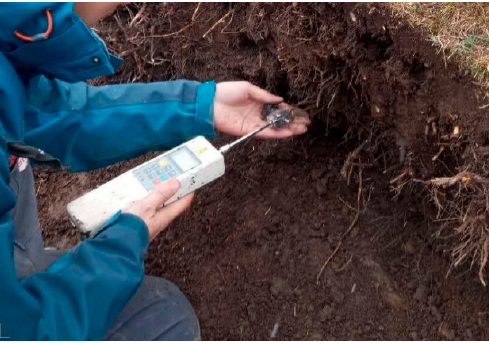
Figure 4. Measuring the maximum pullout force of individual roots using a tension meter.